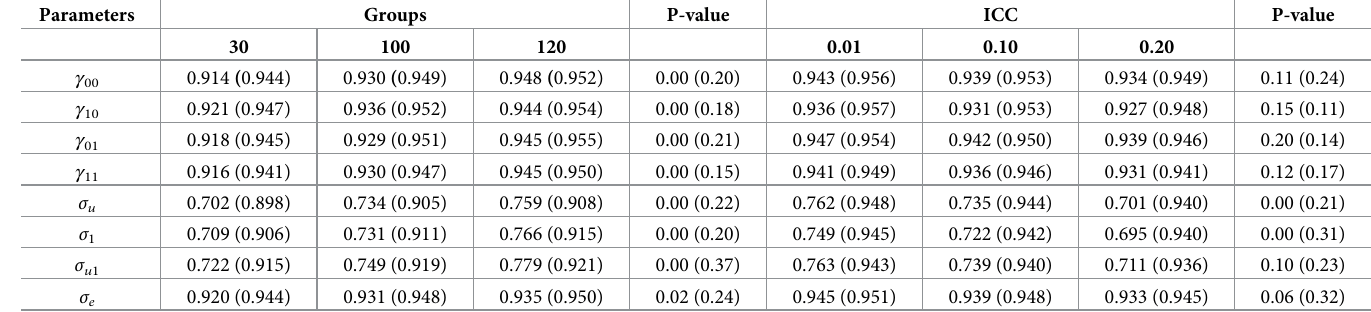
Table 9. Impact of groups and ICC on estimates 95% coverage probability for exponential distribution data (First = REML estimation procedure, Second = Percentile bootstrap estimates are enclosed in parenthesis). Parameters